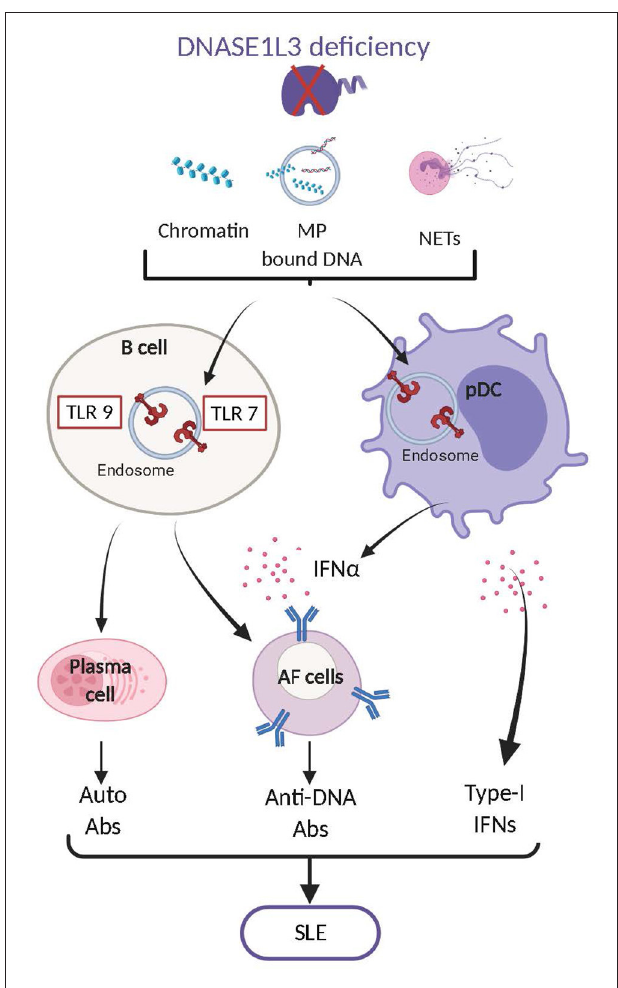
FIGURE 2 | DNASE1L3 deficiency leads to the accumulation of numerous forms of DNA including chromatin, MP associated DNA and NET-associated DNA. Accumulation of such DNA contributes to the aberrant activation of TLR7,9 in B cells and plasmacytoid dendritic cells (pDCs). In B cells TLR7,9 activation leads to their differentiation into plasma cells and antibody forming cells (AFC) that produce autoreactive antibodies mostly directed against dsDNA. In pDCs TLR7,9 activation induces the production of type I interferons (IFN-I) which also play an important role in the transition of B cells into AFC. The production of anti-dsDNA antibodies and of IFN-I will ultimately cause the development of Systemic Lupus Erythematosus